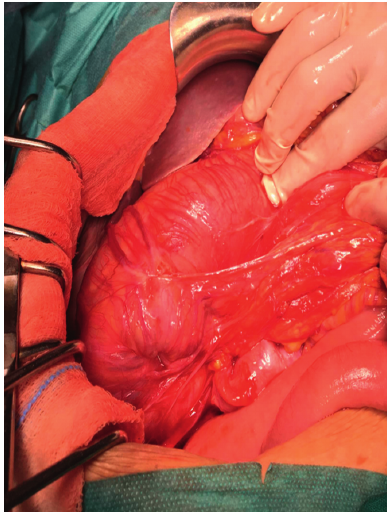
Figure 5: Operative image showing colocolic intussusception.